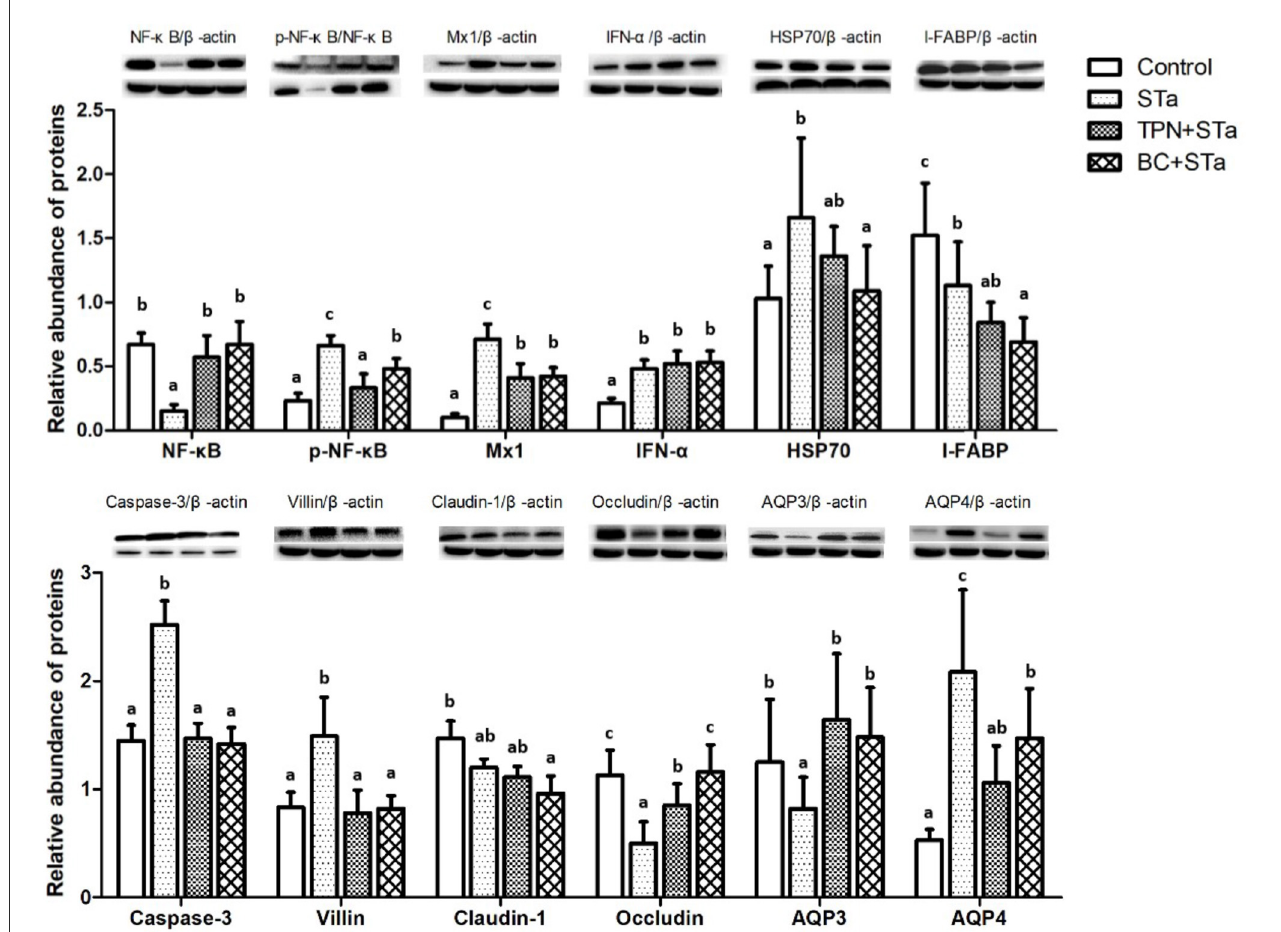
FIGURE2 Effects of TPN and B. coagulans supplementation on the expression of proteins associated with intestinal barrier, immunity and metabolism in the jejunum of ETEC infected weaned piglets. Bars not sharing a common lowercase letter differ significantly ( p <